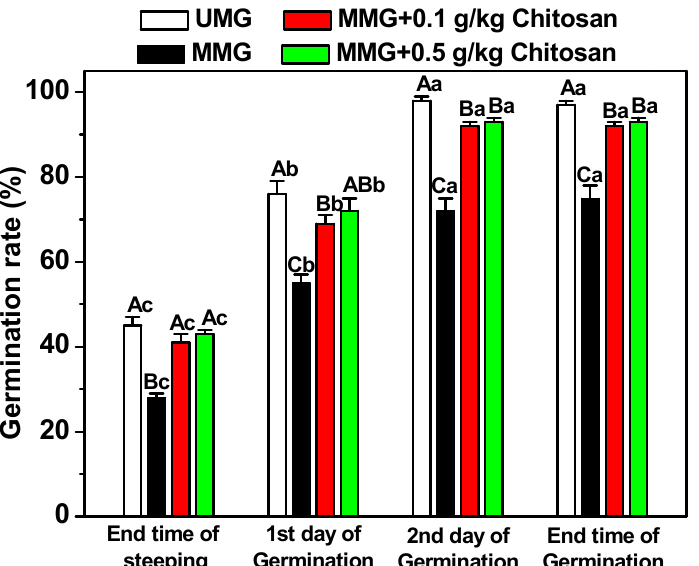
Figure 4. Germination rate of uninfected malt grains (UMG), mixed malt grains (MMG) and MMG treated with 0.1 g/kg of chitosan or 0.5 g/L of chitosan. Each number represents the mean ± standard deviation of three replicates. Within the same malting step and among different treatment conditions, different capital letter superscripts indicate significant differences ( p < 0.05); within the same treatment condition and among different malting steps, different lowercase superscripts indicate significant differences ( p < 0.05).